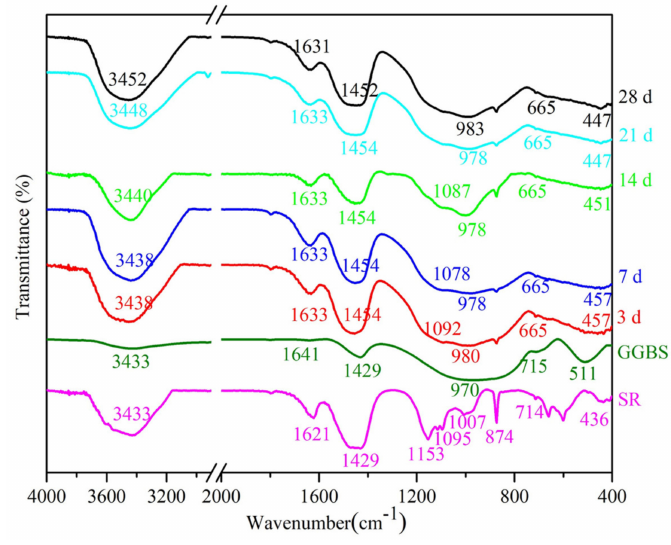
Figure 8. FTIR spectra of SR, GGBFS and SG2 at different curing times (3, 7, 14, 21, and 28